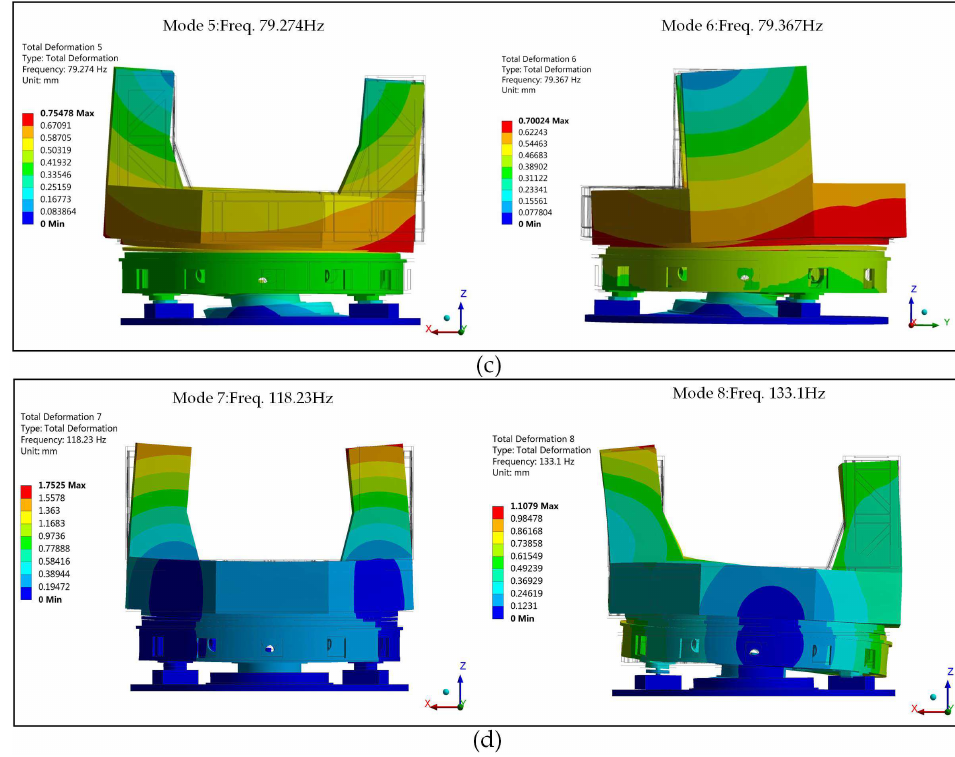
Figure 13. Mode shape diagram of the optimized model. ( a ) The first and second order mode shapes. ( b ) The third and fourth order mode shapes. ( c ) The fifth and sixth order mode shapes. ( d ) The seventh and eighth order mode shapes.